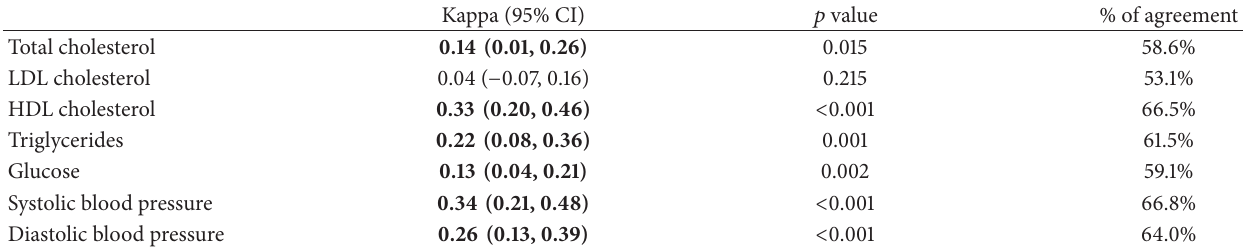
Table 3: Classification agreement using the derived WHtR cut-point and cardiometabolic blood marker